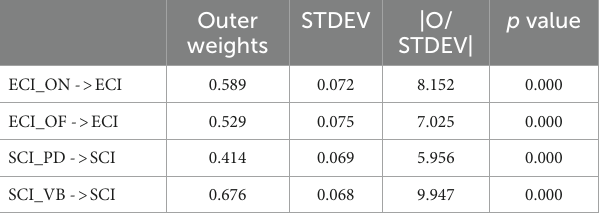
TABLE 4 Outer weights of interaction construct and their